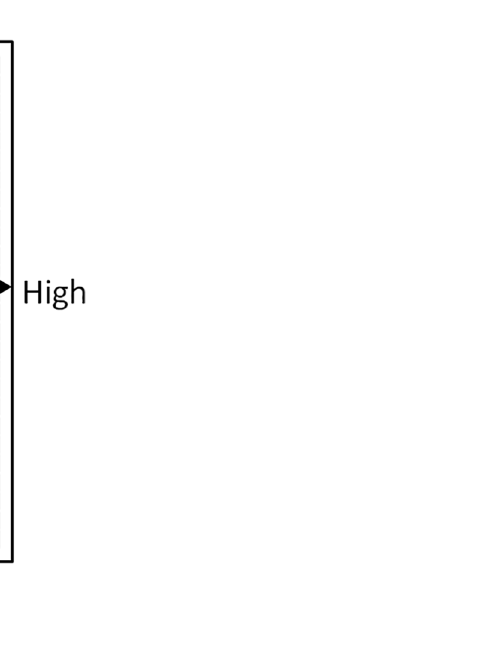
Figure 3. The conceptual association between obsessive- and harmonious passion, indicating the approximate position of Evelyn's scores with the black